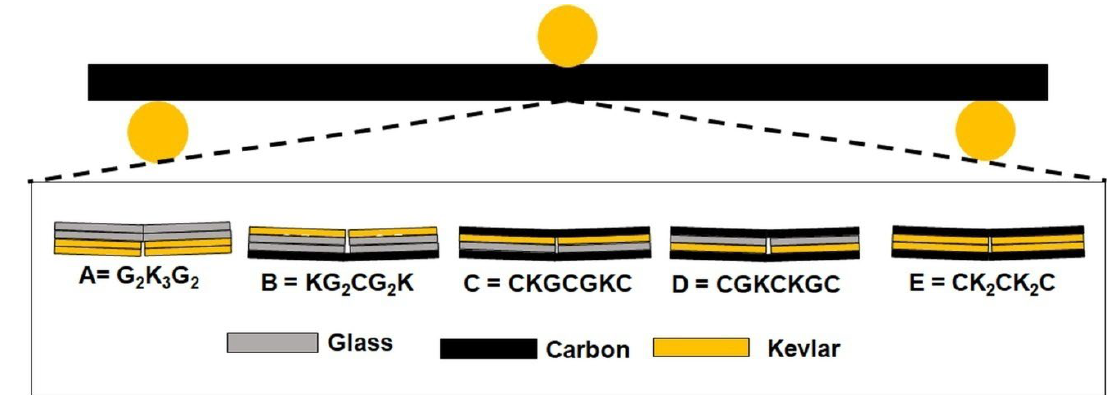
Figure 5. Schematic diagram of failed hybrid composites under three-point bending load. Table 2. Specific flexural strength and modulus of